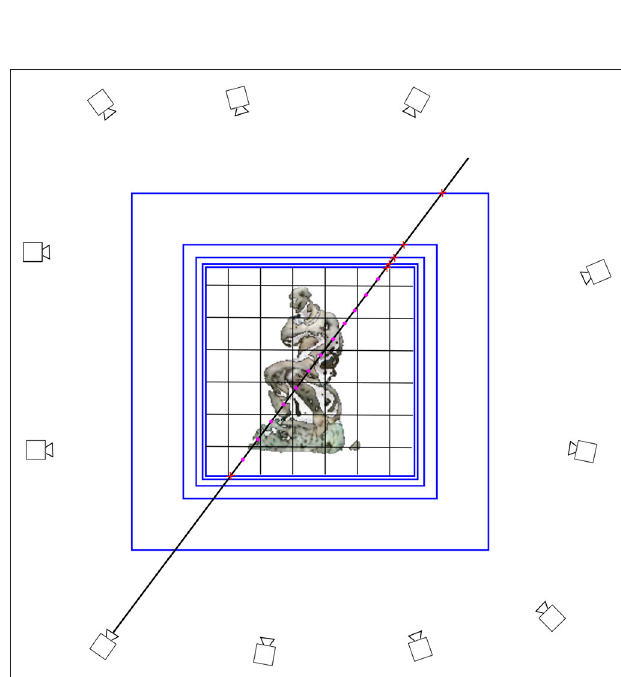
FIGURE 2 | Environment maps surround the scene, improving convergence and allowing for separation of foreground and background.